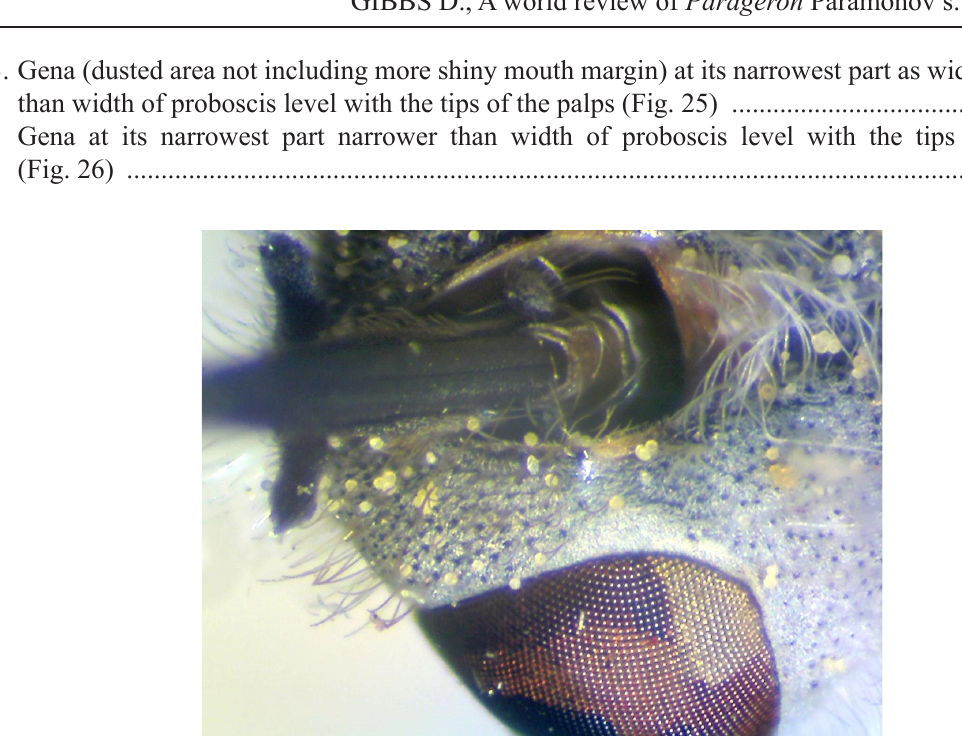
Fig. 25. Protypusia argentata gen. et sp. nov., ♀.